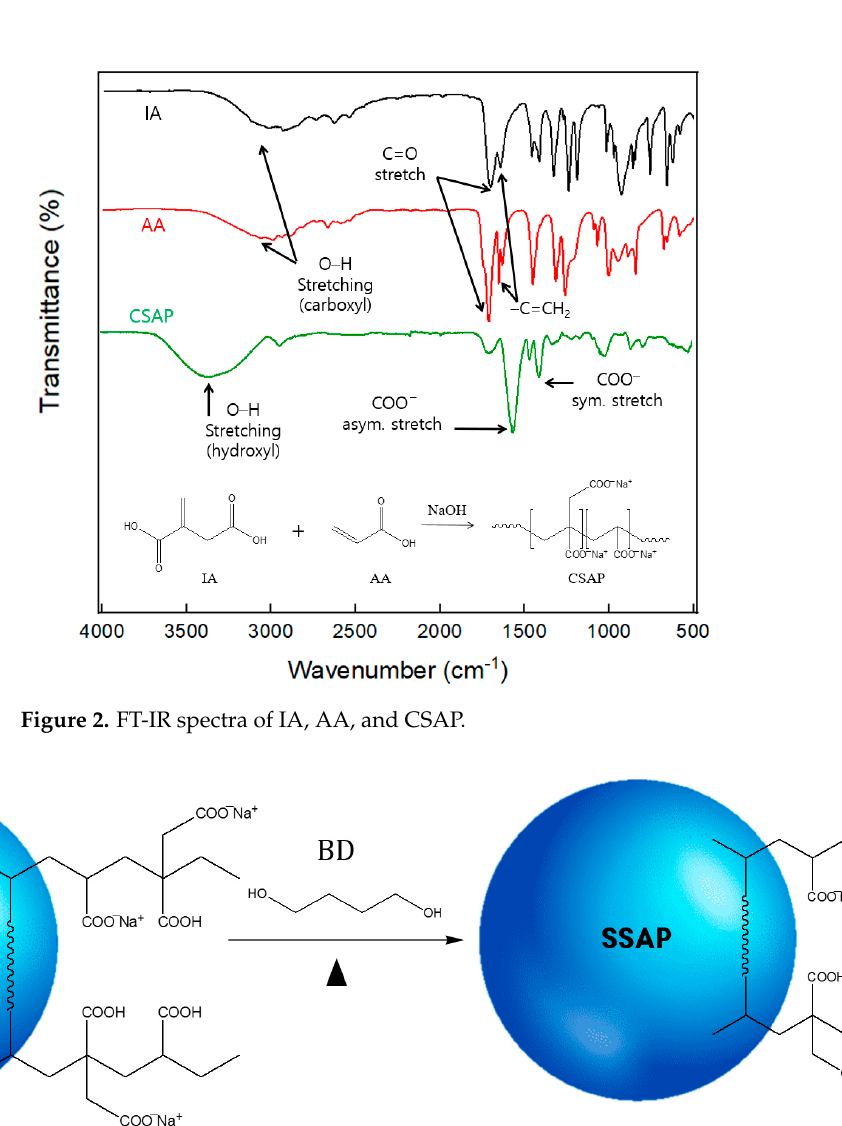
Figure 3. A schematic diagram of the surface-crosslinking